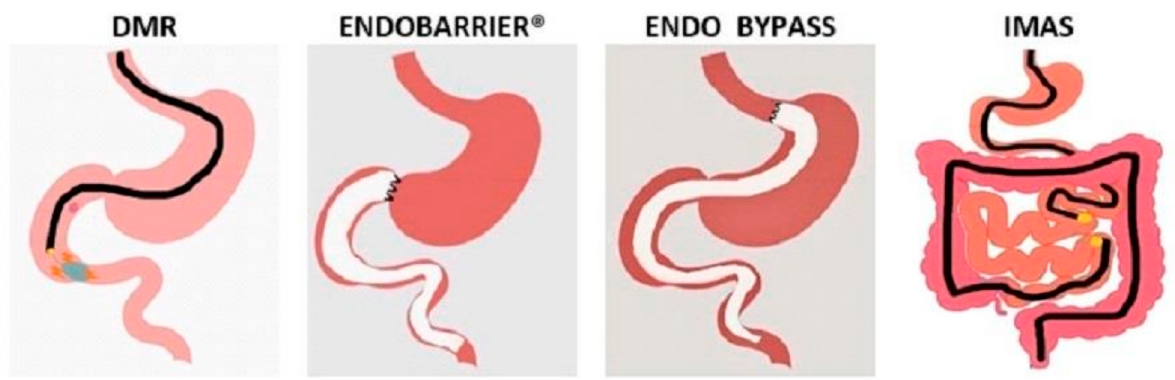
Figure 4. Schematic representation of the endoscopic malabsorptive procedures. IMAS, Incisionless Magnetic Anastomotic System; DMR, duodenal mucosal resurfacing.